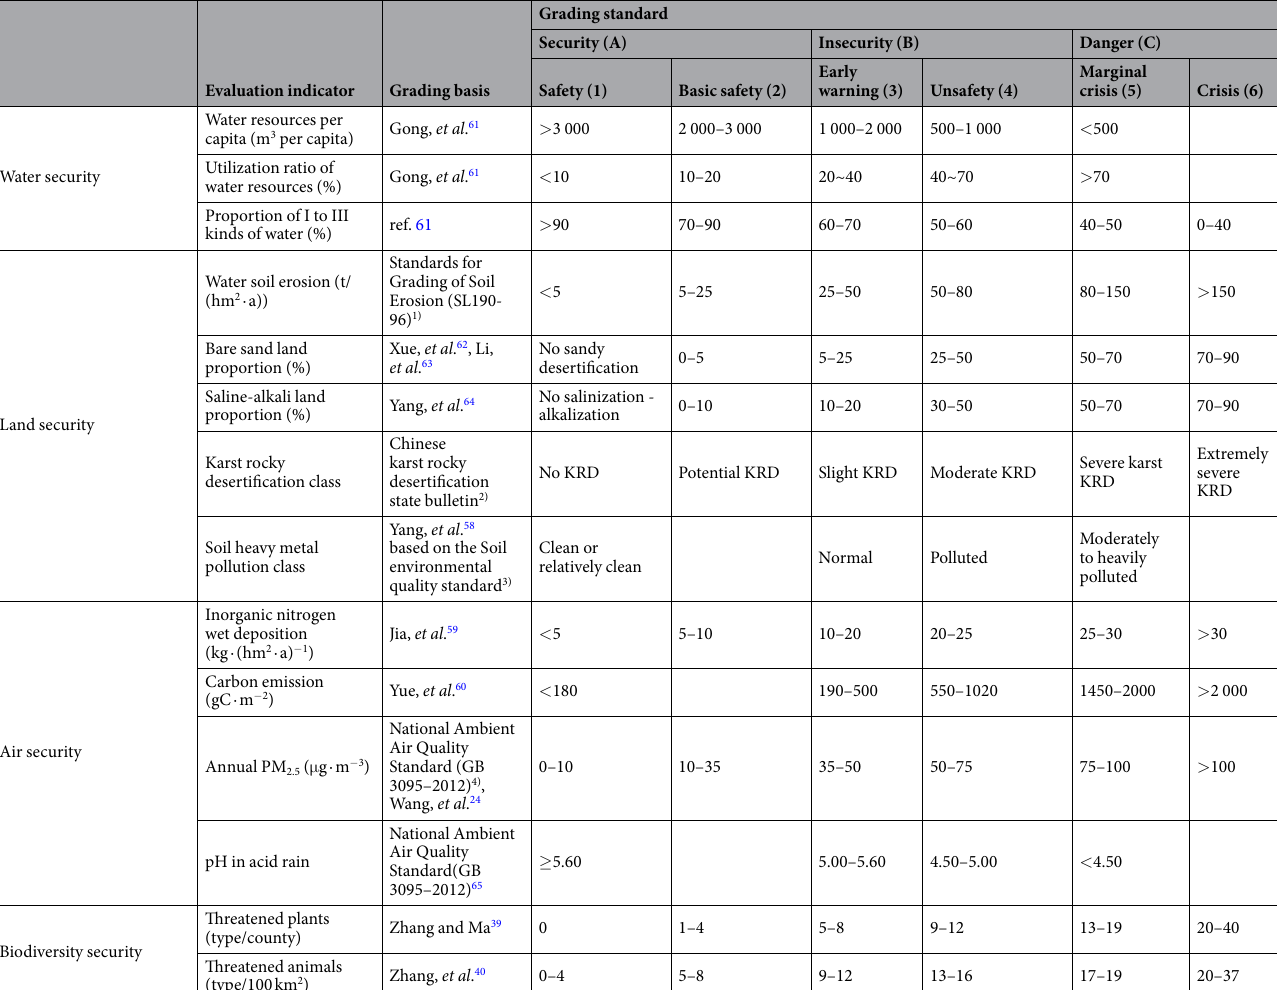
Table 3. Grading standards of evaluation indicators for the ecological and environmental security. Note: 1) Ministry of Water Resources of the People’s Republic of China, 1997, SL190-96 Standards for Grading of Soil Erosion. (in Chinese). 2) State Forestry Administration of People’s Republic of China, 2012, China karst